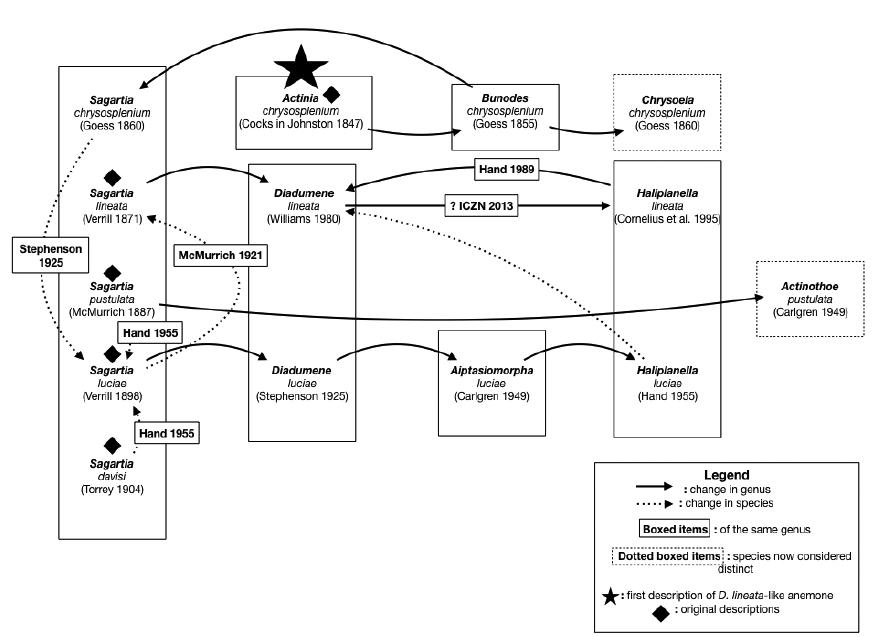
Figure 4. Synonymy flowchart, including misidentifications (i.e., Chrysoela chrysosplenium and Acti- nothoe pustulata ). Synonyms based on misspellings have been